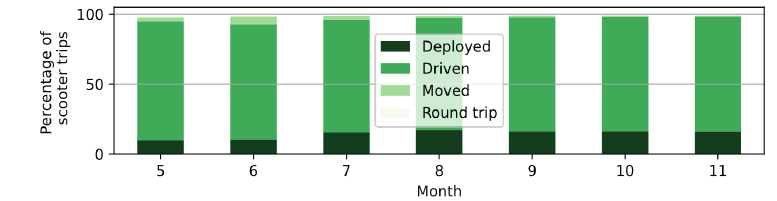
Fig. 3. Scooter ride proportions by